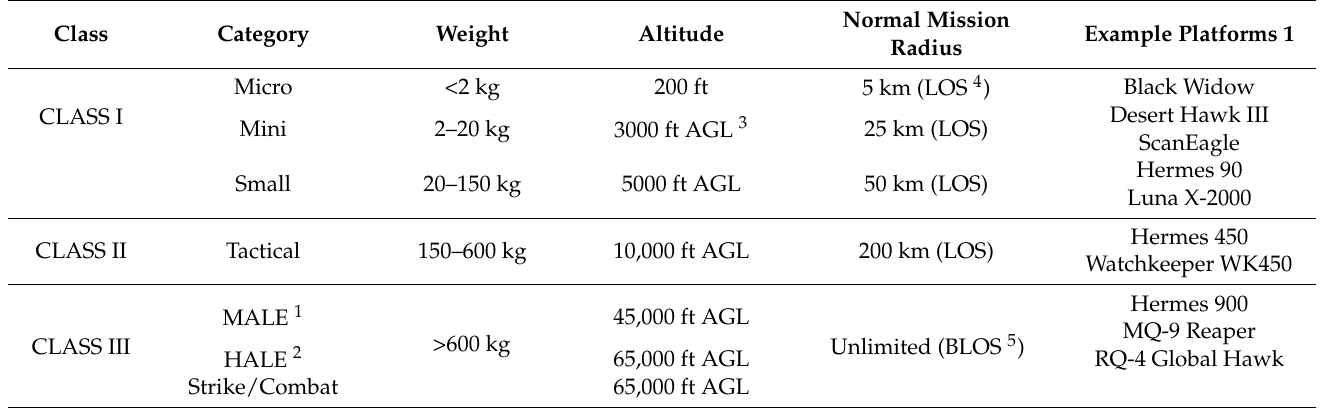
1 MALE—Medium Altitude Long Endurance. 2 HALE—High Altitude Long Endurance. 3 AGL—Above Ground Level. 4 LOS—Line of Sight. 5 BLOS—Beyond Line of